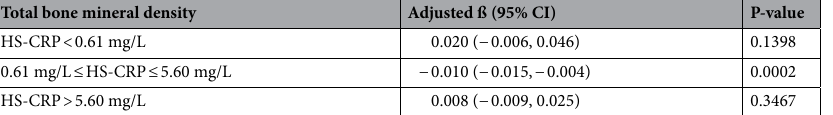
Table 3. Threshold effect analysis of HS-CRP on total bone mineral density using piece-wise linear regression. Age, gender, race, BMI, income-poverty ratio, education level, alkaline phosphatase, cholesterol, calcium, phosphorus, globulin, and total protein were adjusted.